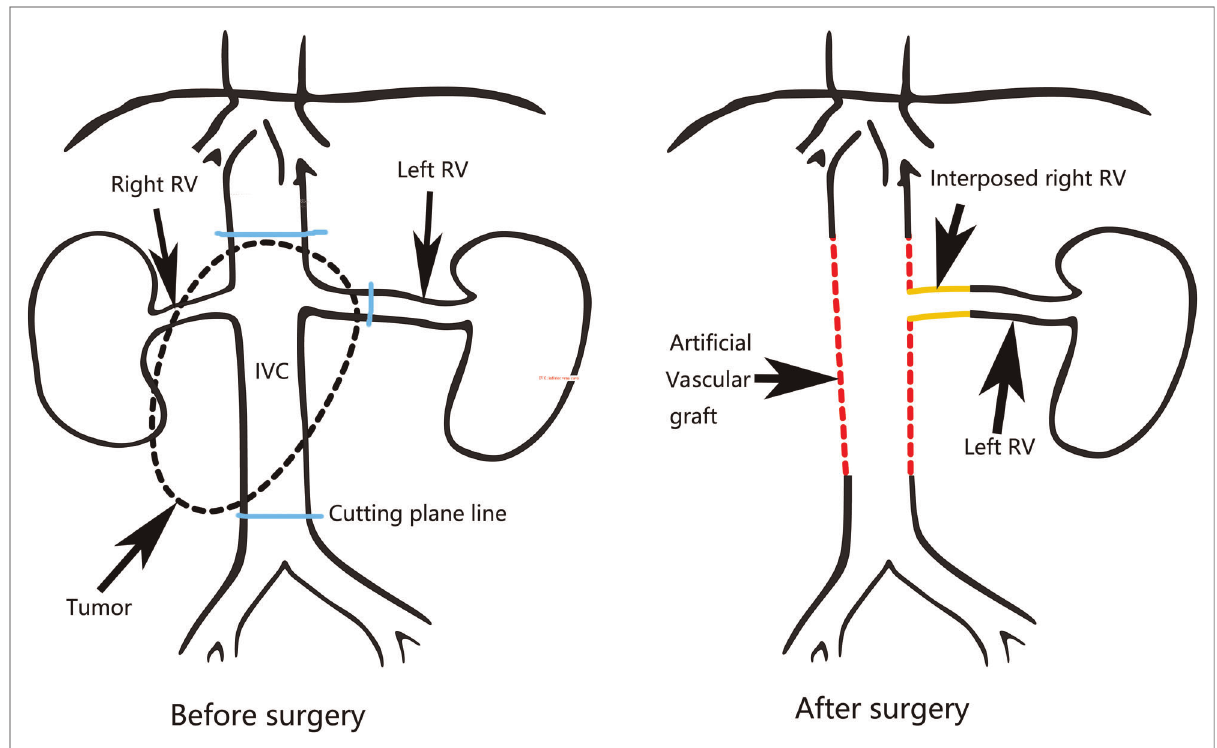
FIGURE 3 The drawing of the procedure. RV, Right vein; IVC, inferior vena